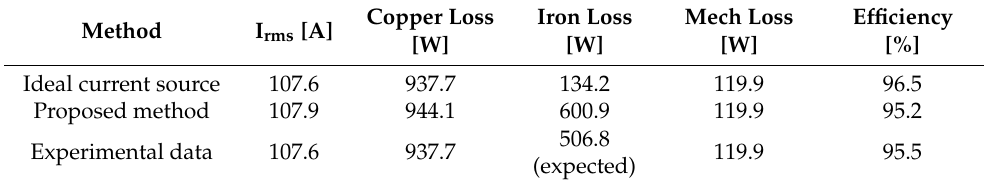
Table 7. Case 4: 125 Nm at 2500 rpm.